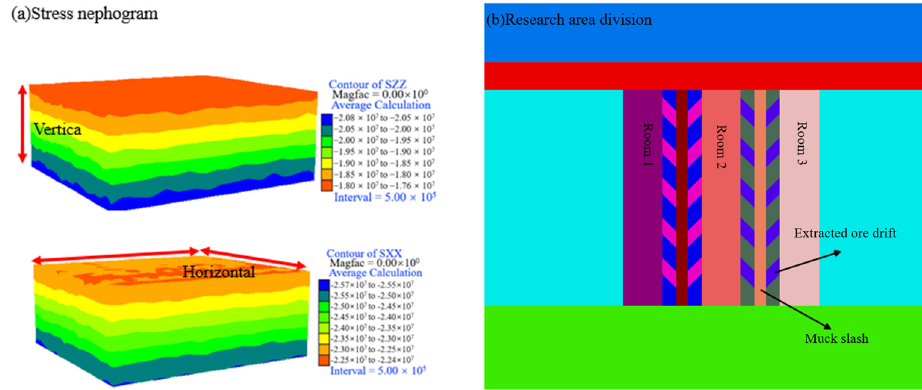
Figure 3. Initial diagram of the calculation model. ( a ) Stress nephogram ( b ) Research area division.